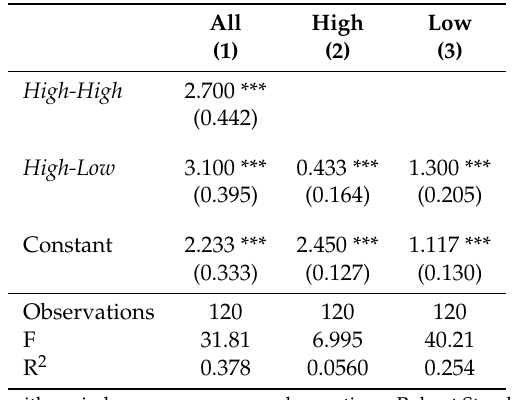
Table A6. Linear regressions: average number of subjects per group who help in Part B—merged group treatment.